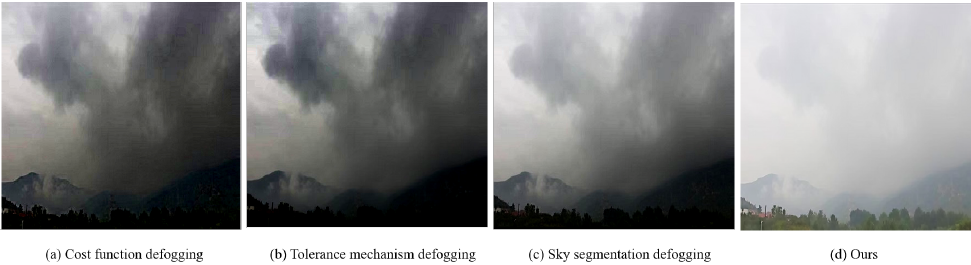
Figure 5. Comparison results of different defogging algorithms, including cost function defogging algorithm [16], tolerance mechanism defogging algorithm [12], sky segmentation algorithm [15], and our proposed